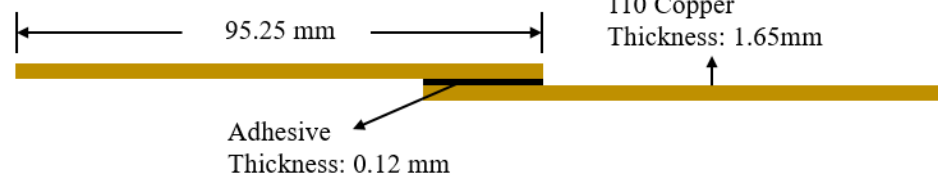
Figure 3. Schematic figure for the single-lap shear joints.